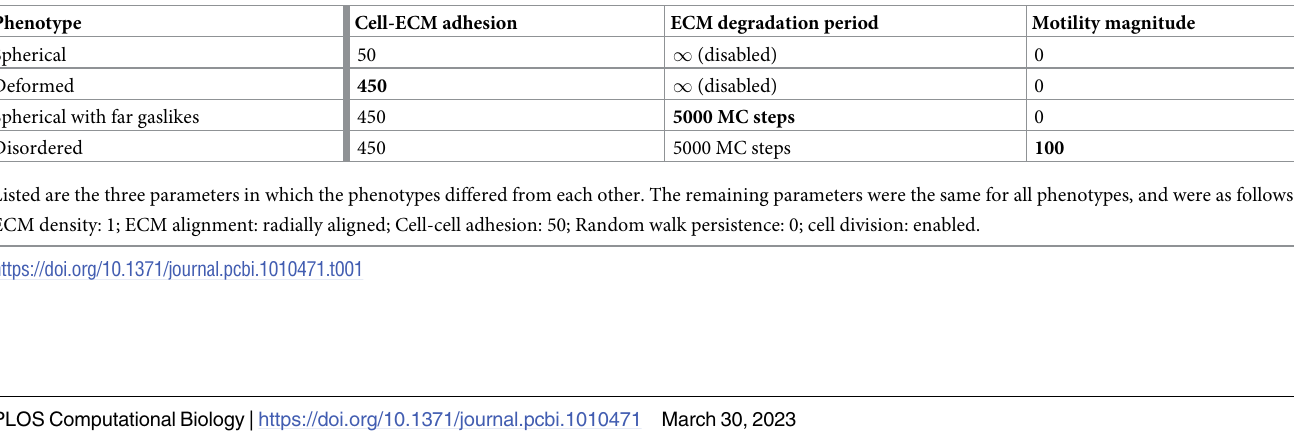
Table 1. Differences between the four simulated phenotypes used throughout this